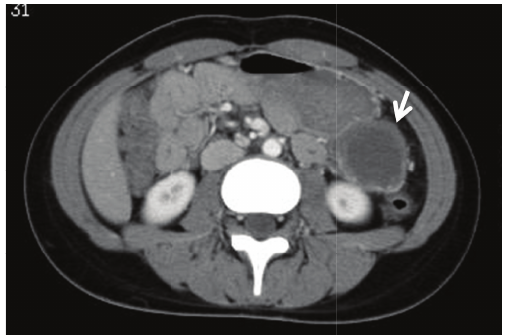
Figure 2: CT at three months after rupturing tumor. A cystic tumor is shown (arrow), protruding caudally from the pancreatic tail. The fluid around tumor had disappeared.